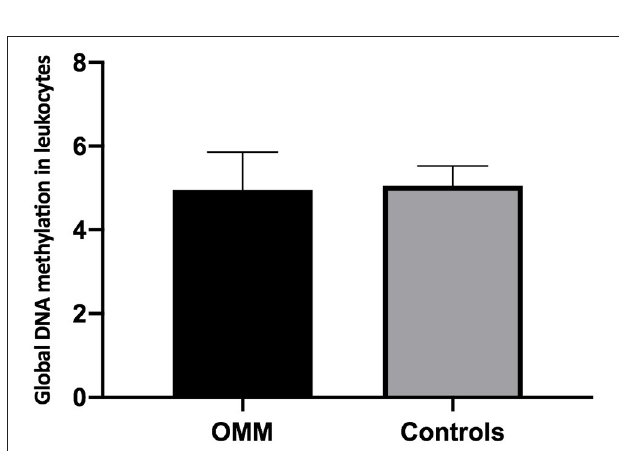
FIGURE 5 | Quantification of global DNA methylation in peripheral blood leukocytes from dogs bearing melanotic and amelanotic OMM or control dogs. No statistical differences were obtained when means were compared by the Student’s t -test ( p > 0.05).